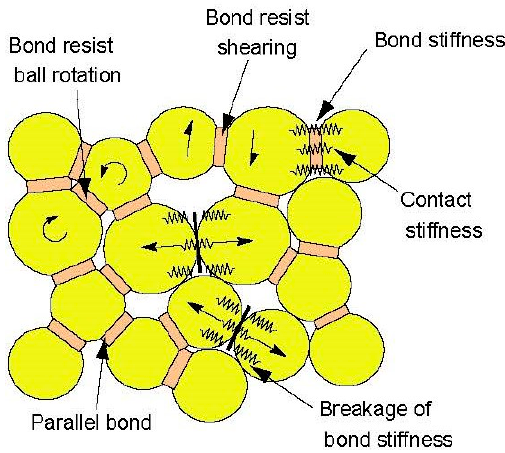
Figure 11. Illustration of parallel bond models provided in PFC (Particle Flow Code) [33].